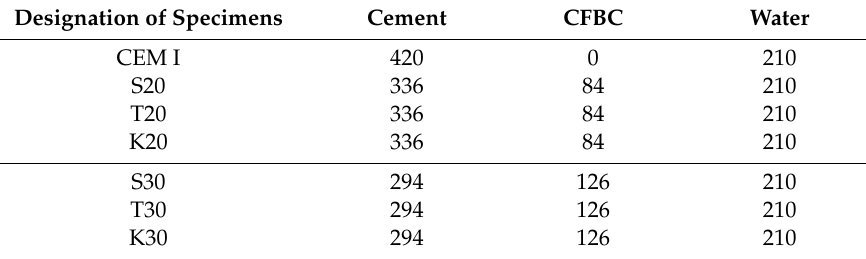
Table 3. Composition of pastes prepared with CEM I and CFBC